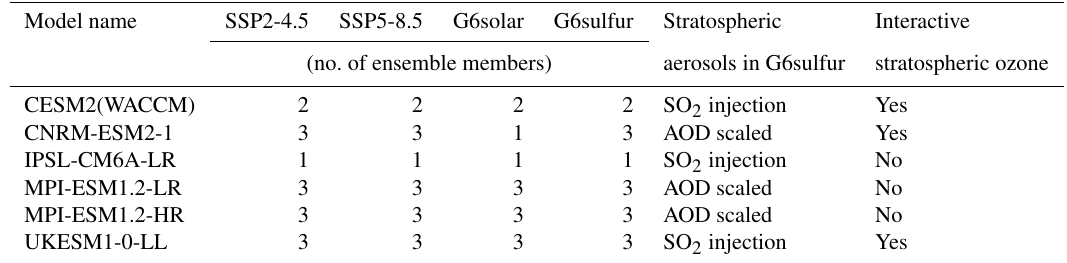
Table 1. Summary of model simulations used in this work (adapted from Visioni et al., 2021b). Model name